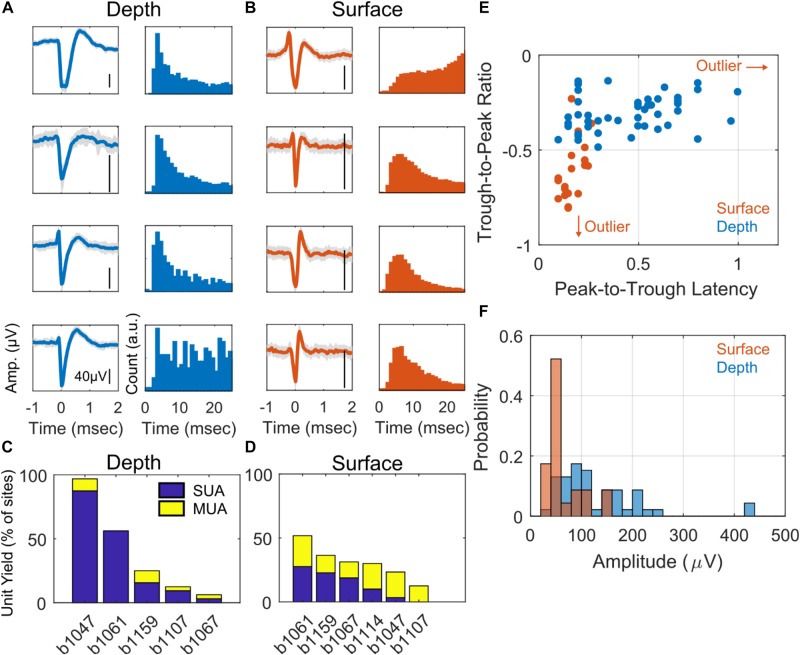
Single unit characteristics. Example of four depth-recorded (A) and four surface-recorded (B) single unit voltage waveforms and the respective inter-spike interval (ISI) histograms. Waveforms are averaged over 50 uniformly sampled spike events. The y-scale bar indicates 40 μV in amplitude. (C) Unit yield for depth (C) and surface (D) arrays as a percentage of total number of contacts. The stacked bar plot shows the percentage of single units (SUA) and multi-units (MUA) for each subject. (E) Scatter plot showing trough-to-peak ratio vs. peak-to-trough interval for all putative neurons (units) recorded from the surface (red) and depth arrays (blue), respectively. The red arrows indicate an outlying sample from a surface SUA in the direction that the arrows point. (F) Histogram of surface (red) and depth (blue) single unit amplitudes in μV.